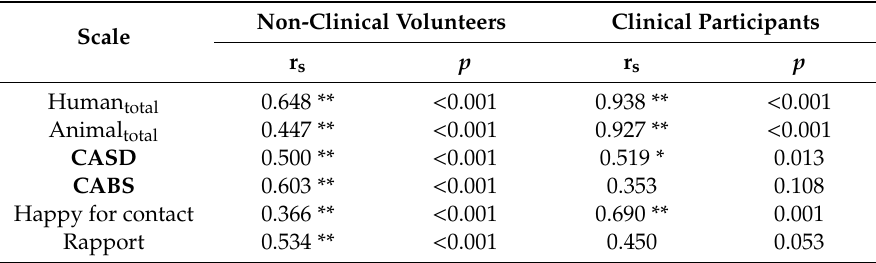
Table 5. Scales and subscales correlations with HAIS total